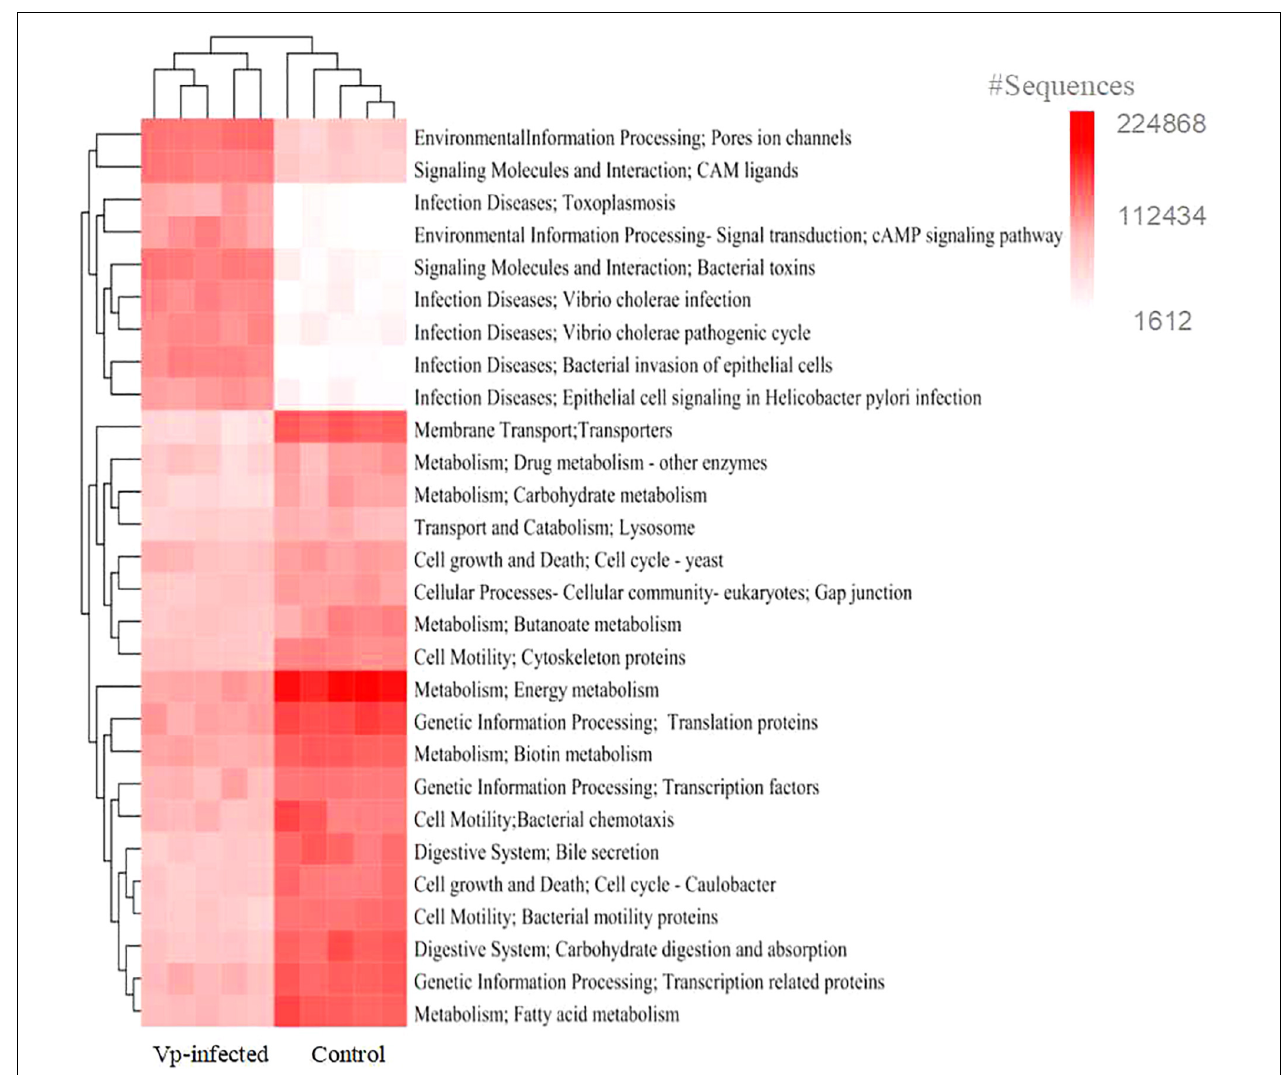
FIGURE 6 | Predicted KEGG pathways of mice gut microbiota. Changes in the abundance of KEGG metabolic pathways in the Vp-infected group relative to the control group at 12 h. The red color intensity indicates the richness of metabolic